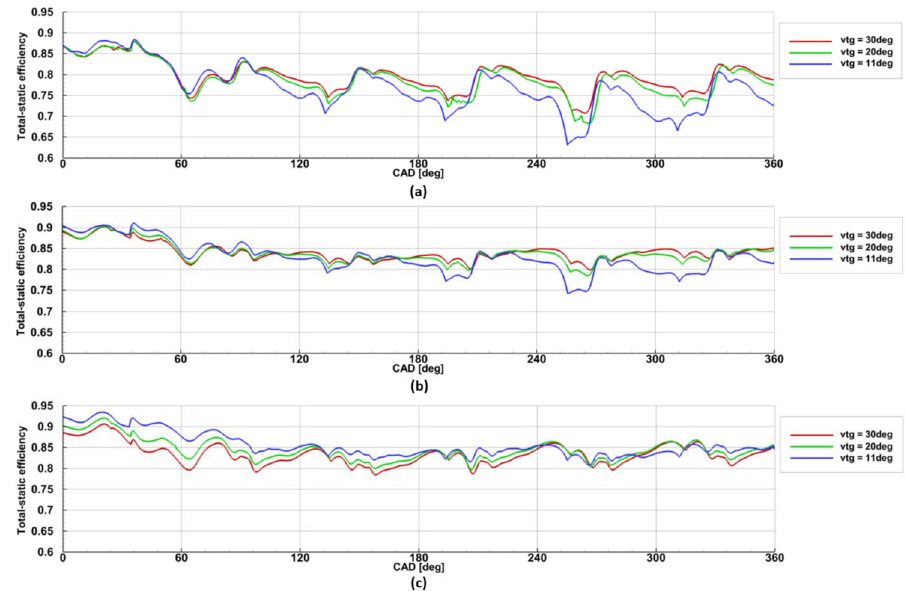
Figure 21. The averaged total-static efficiency of the 1st stage rotor at the three different VTG openings for: ( a ) 60,000 rpm, ( b ) 50,000 rpm, ( c ) 40,000 rpm during the single revolution of the crankshaft. Figure 22 shows the averaged total-static efficiency of the 2nd stage rotor.